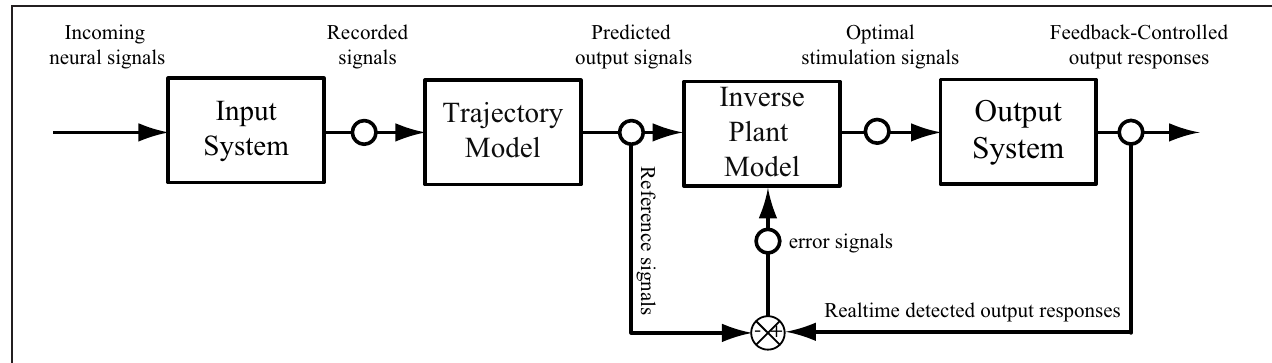
FIGURE 9 | A schematic diagram of a neuroprosthesis implemented with a feedforward and feedback controller.